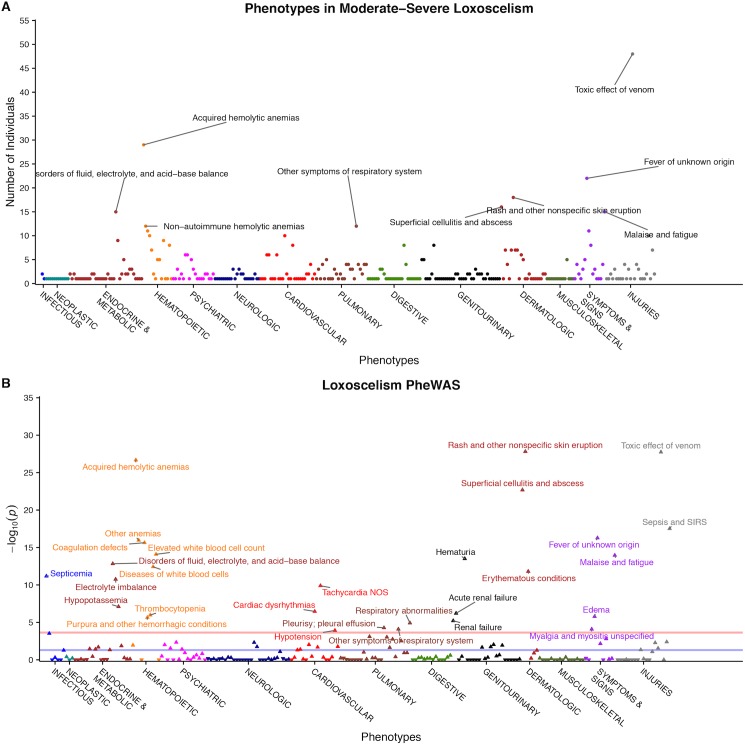
Phenotypes and PheWAS of Individuals with Moderate-Severe Loxoscelism.(A) Manhattan plot representing the number of individuals with moderate to severe loxoscelism with each phenotype. The most frequent phenotypes validated the loxoscelism definition and included the toxic effect of venom, acquired hemolytic anemia, fever of unknown origin, and rash/skin eruption. (B) PheWAS for moderate-severe loxoscelism. The blue line represents significance level without correction (p = 0.05). The red line is representative of the adjusted significance threshold using the Bonferroni correction for multiple comparisons (p = 1.2 x 10−4). 29 phenotypes showed a significant correlation (p < 1.2 x 10−4) with the loxoscelism phenotype when compared to controls.